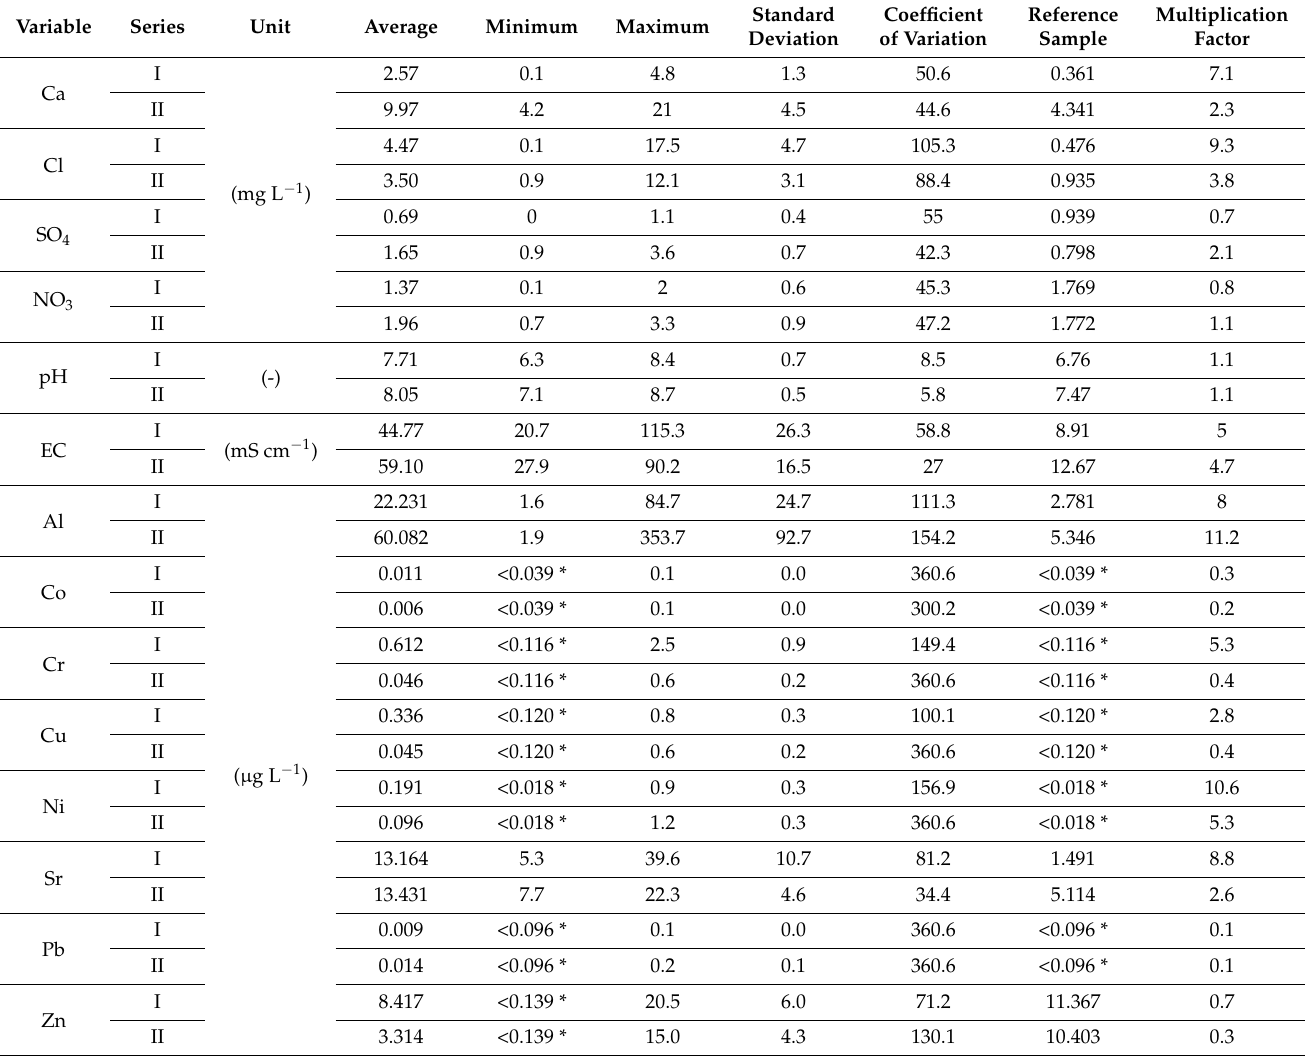
Table 2. Physico-chemical and chemical properties of the snow samples taken